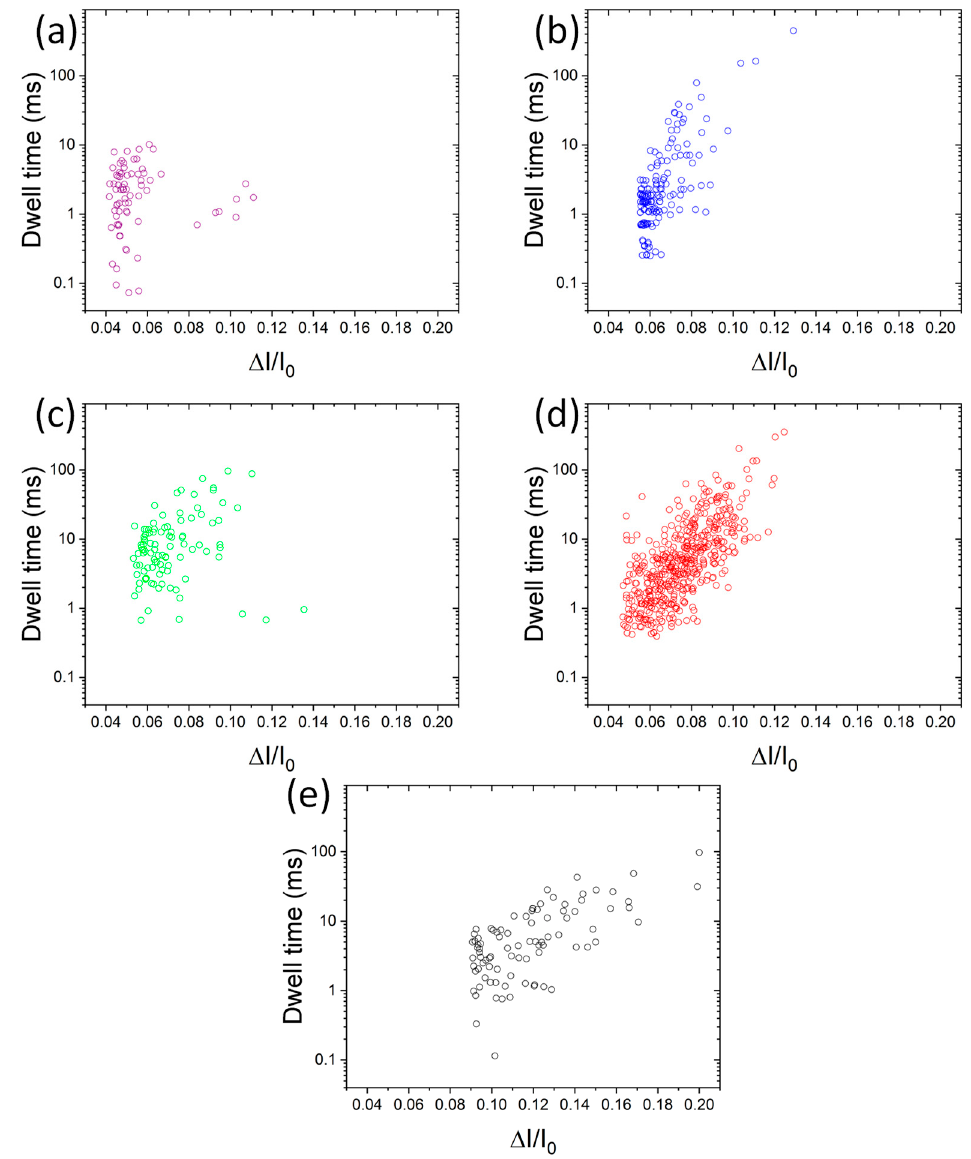
Figure 3. Events map of blockade parameters induced by peroxidase-AuNP (( a ), purple), BSA-AuNP (( b ), blue), glucose oxidase-AuNP (( c ), green), avidin-AuNP (( d ), red), β -lactoglobulin-AuNP (( e ), black).